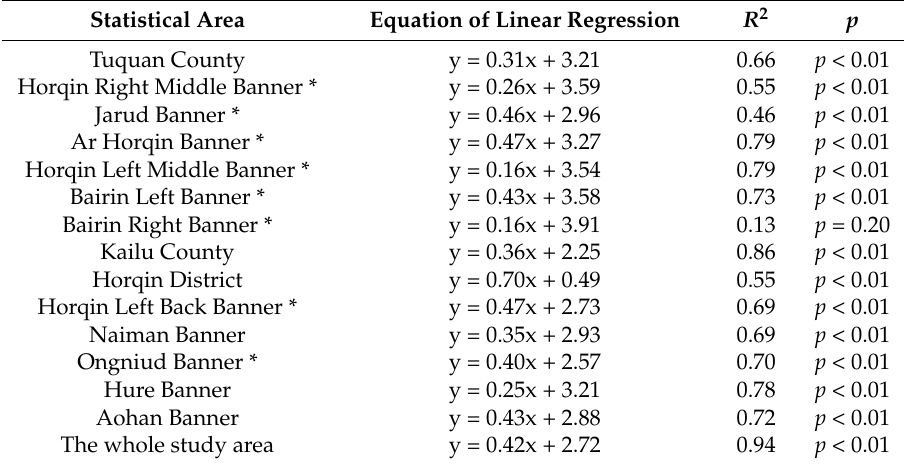
Figure 8. Change in millet yield per unit and average NDVI of cropland in the entire study area. Table 5. Results of simple linear